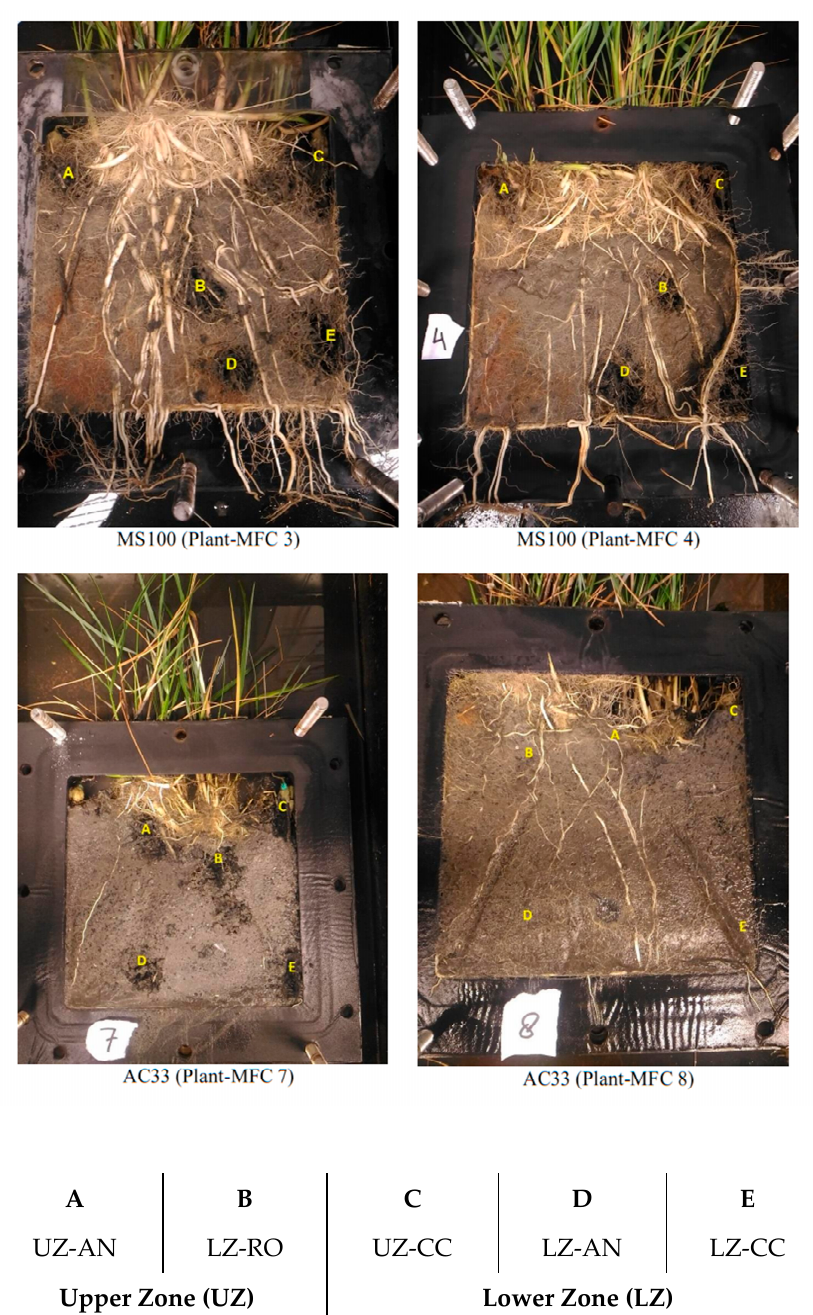
Figure 2. DNA analysis sampling points.